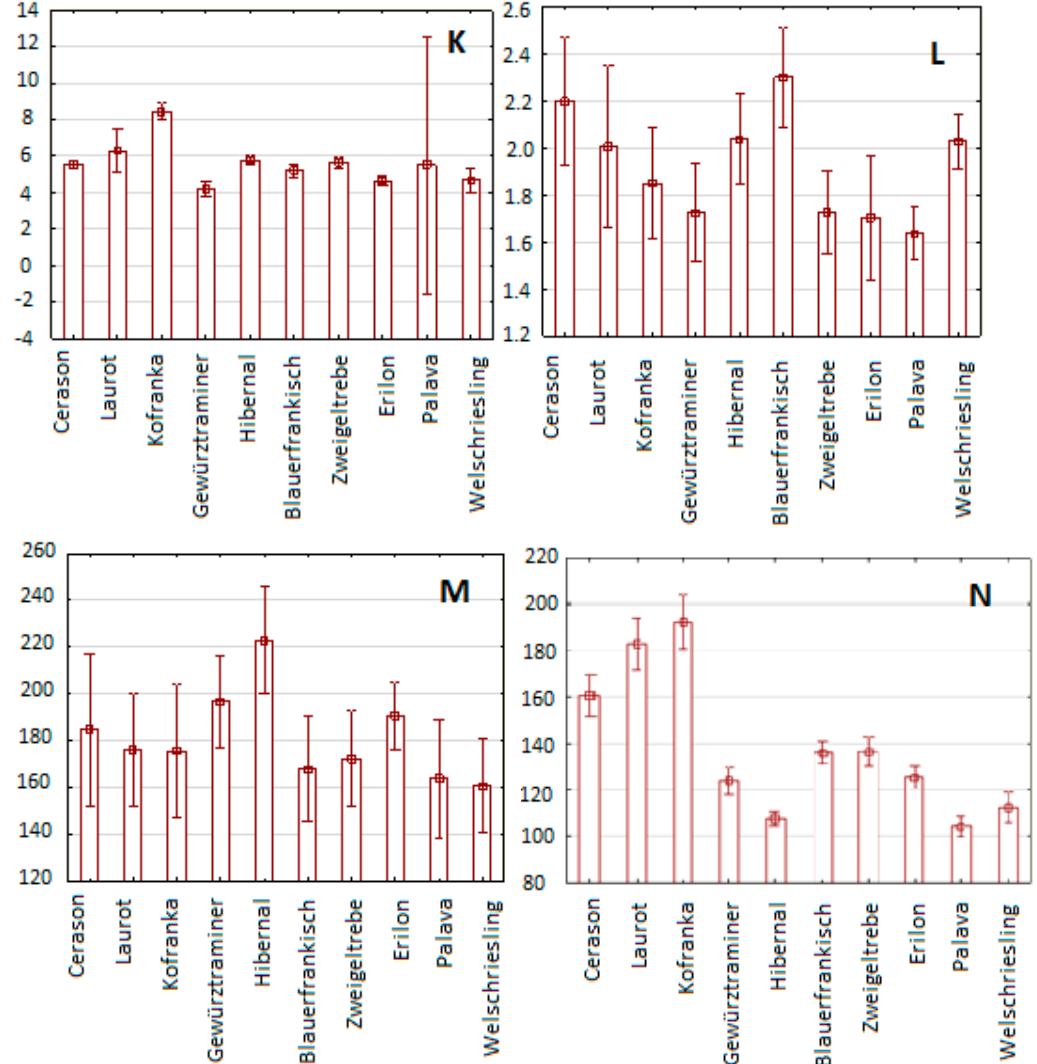
Figure 6. Content of selected antioxidant components in individual grape varieties: gallic acid ( A ), caffeic acid ( B ), coumaric acid ( C ), coutaric acid ( D ), ferulic acid ( E ), fertaric acid ( F ), trans-piceid ( G ), trans-piceatannol ( H ), rutin ( I ), quercetin-3- β -D-glucoside ( J ), quercitrin ( K ), myricetin ( L ), catechin ( M ), and epicatechin ( N ). Results are expressed in µg/g of dry matter.